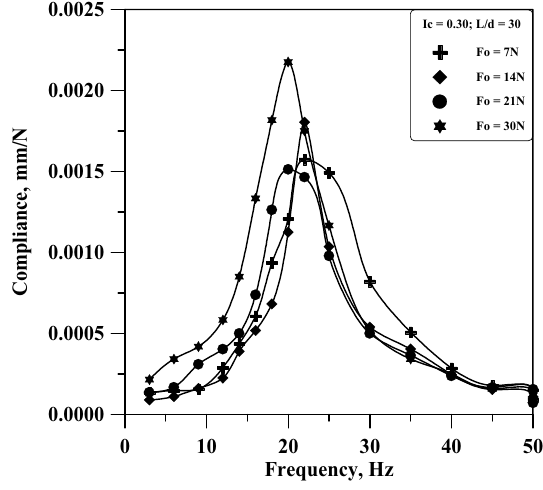
Fig. 7. Normalized frequency response curve for I c = 0.30; L/d =